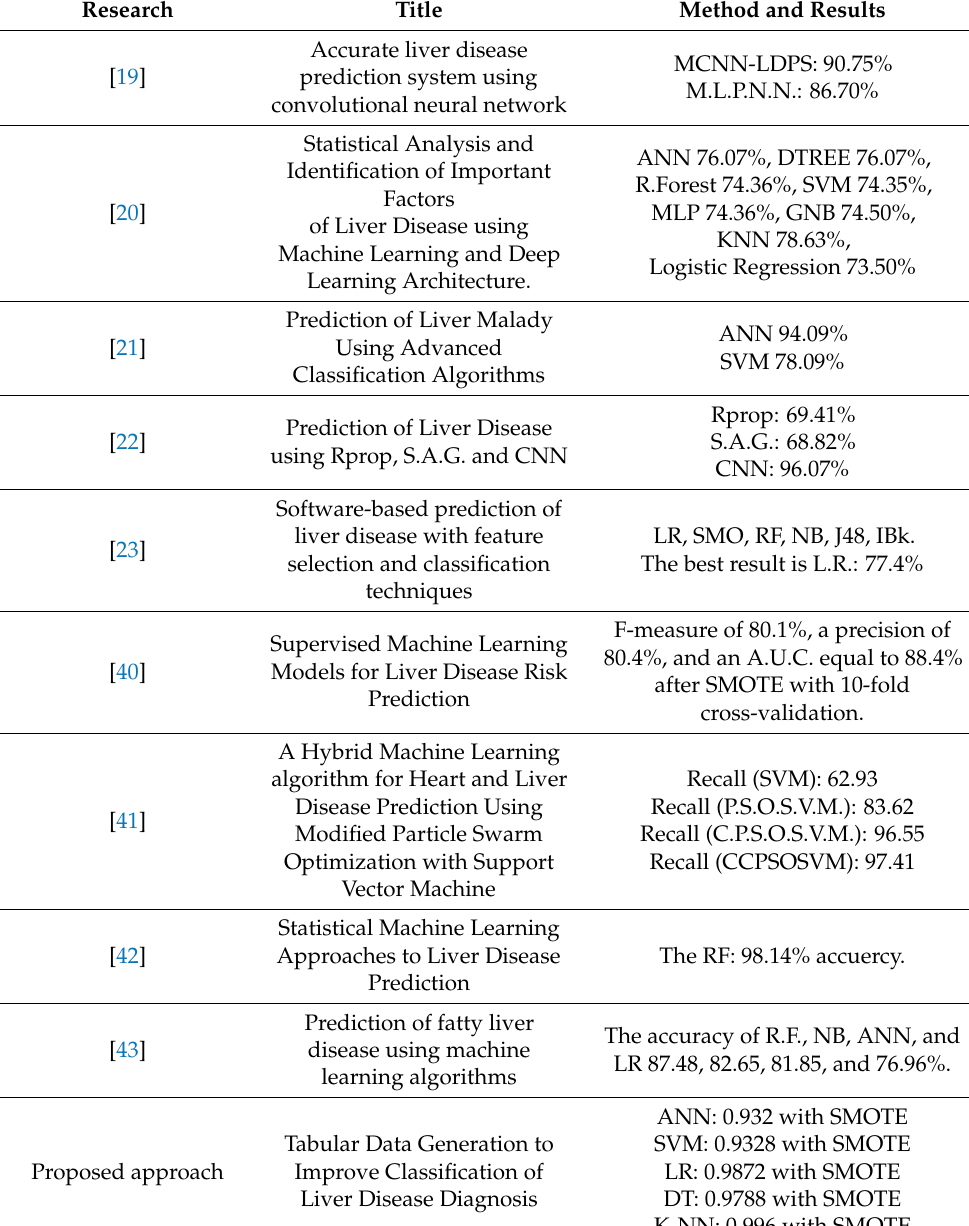
Table 7. Comparison with other research